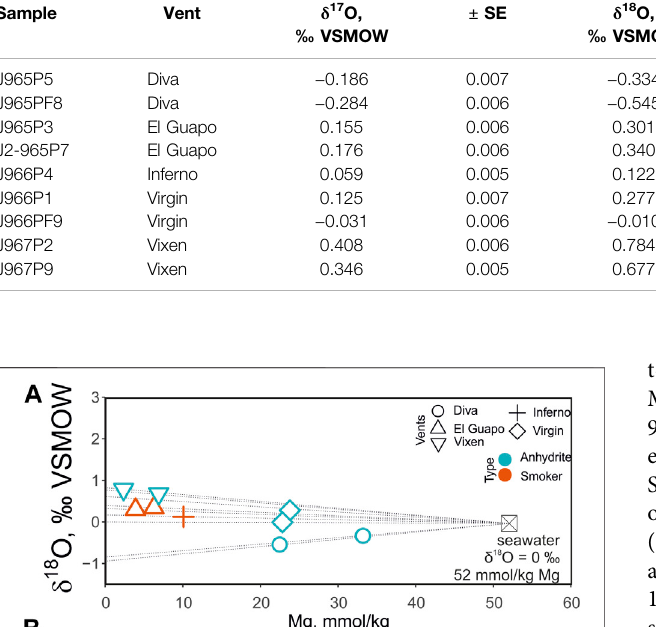
TABLE 2 | Triple oxygen and strontium isotope values measured in fl uids from the Axial Seamount. Sample